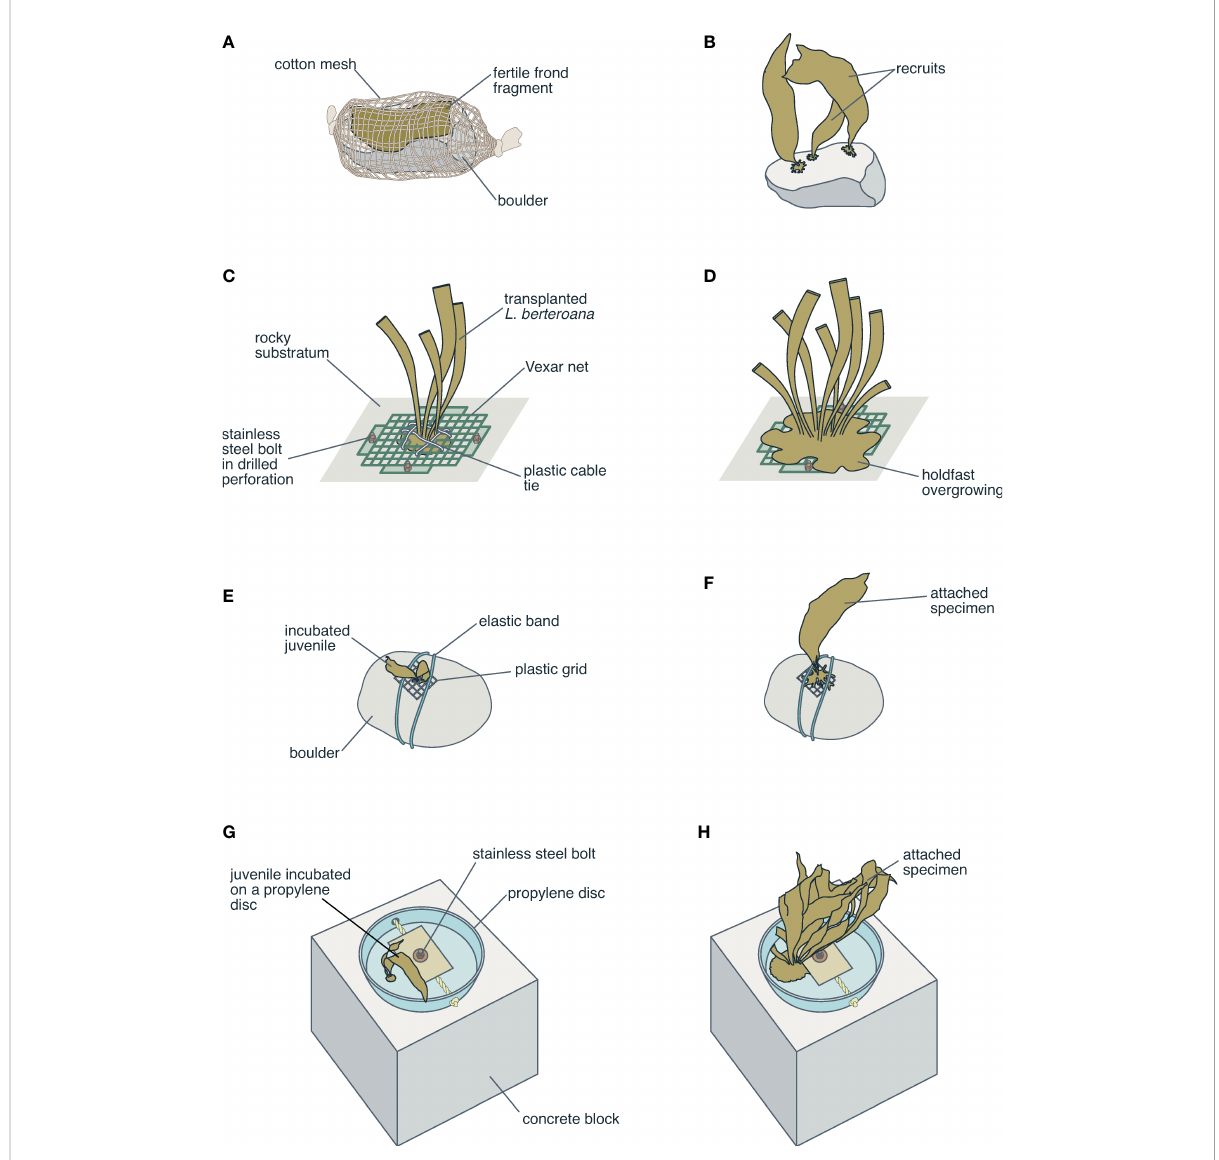
FIGURE 4 Illustration representing restocking techniques used for brown seaweeds in Chile. (A, B) Boulder with cotton mesh and fertile frond of M. pyrifera for sowing spores (Westermeier et al., 2012a; Westermeier et al., 2012b). (C, D) Anchoring system of L. berteroana sporophytes on rocks (Correa et al., 2006). (E, F) Seeding juvenile of M. pyrifera on boulders with elastic band and plastic grids (Westermeier et al., 2012a). (G, H) Disk- anchoring system requiring incrustation into the rock for L. berteroana sporophytes (A ́ vila et al.,